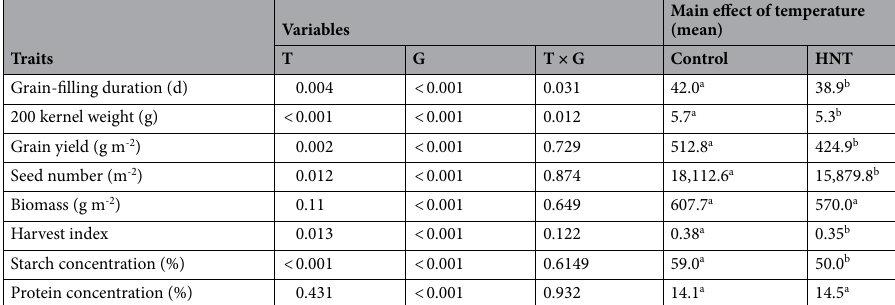
Table 2. Probability values of effects of temperature (T), genotype (G) and T × G interaction on biomass, grain yield and quality traits. Means were separated using Tukey’s honest significant difference (HSD) test at p = 0.05 and statistically significant differences (p < 0.05) between control and HNT effects are indicated by superscripts.